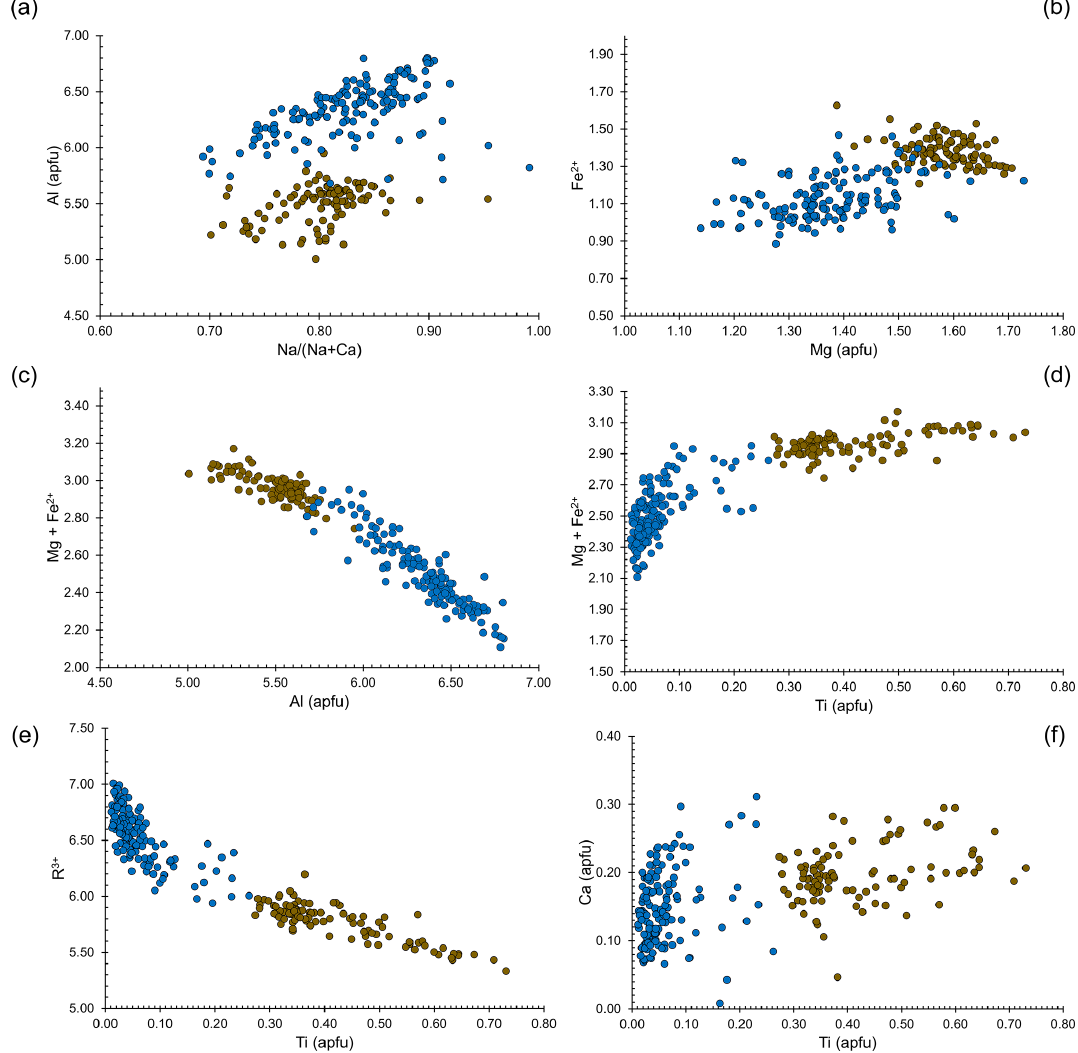
Figure 5. Relations between chemical constituents in dutrowite (brown circles) and associated oxy-dravite (blue circles).